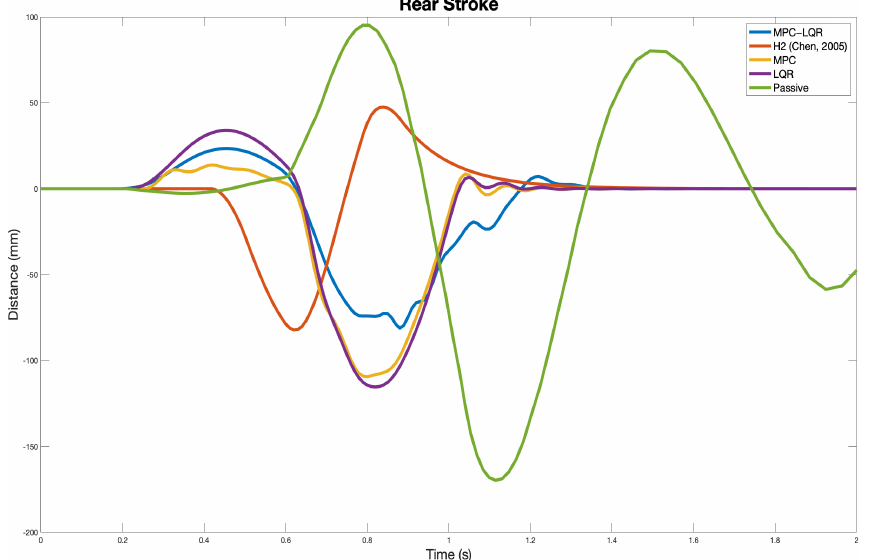
Figure 9. Rear Stroke (Blue—MPC-LQR, Red—H2, Yellow—MPC, Purple—LQR,